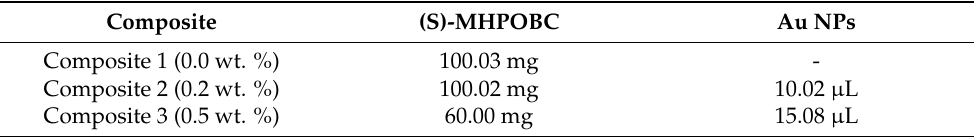
Table 2. Mass and volume compositions of pure (S)-MHPOBC and nanoparticle solutions in toluene of Composites 1–3.